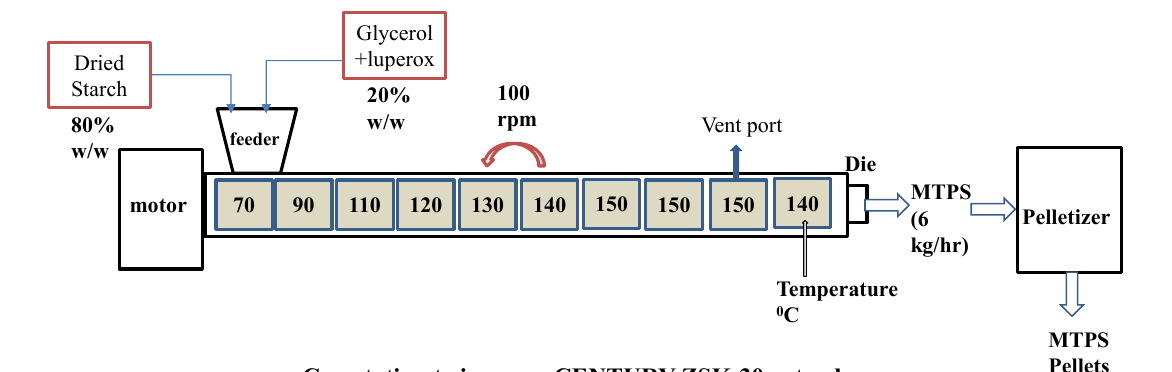
Figure 2. Preparation of maleated thermoplastic starch (MTPS) using reactive extrusion. Table 2. Sample name and